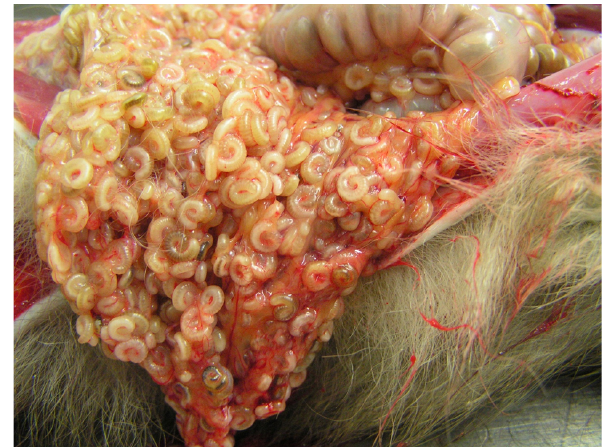
Figure 5. Macroscopic findings in a cynomolgus macaque ( Macaca fascicularis ) from a diagnostic necropsy. Abundant amounts of en- cysted parasitic larvae in the abdominal viscera. In this case of a pentastomiasis PCR was done. The sequence matched 98% that of Armillifer agkistrodontis